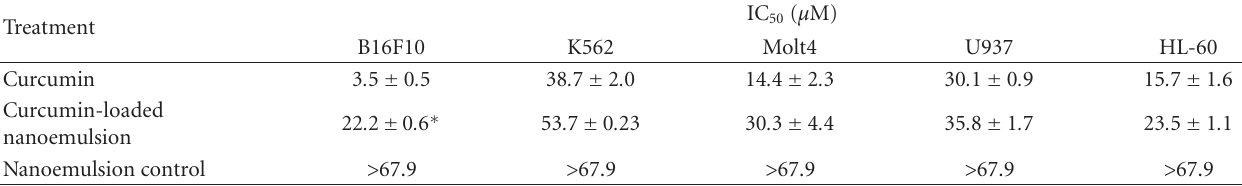
Table 2: IC 50 values ( μ M) of curcumin and curcumin-loaded nanoemulsion on B16F10, K562, Molt4, U937, and HL-60 cell lines.